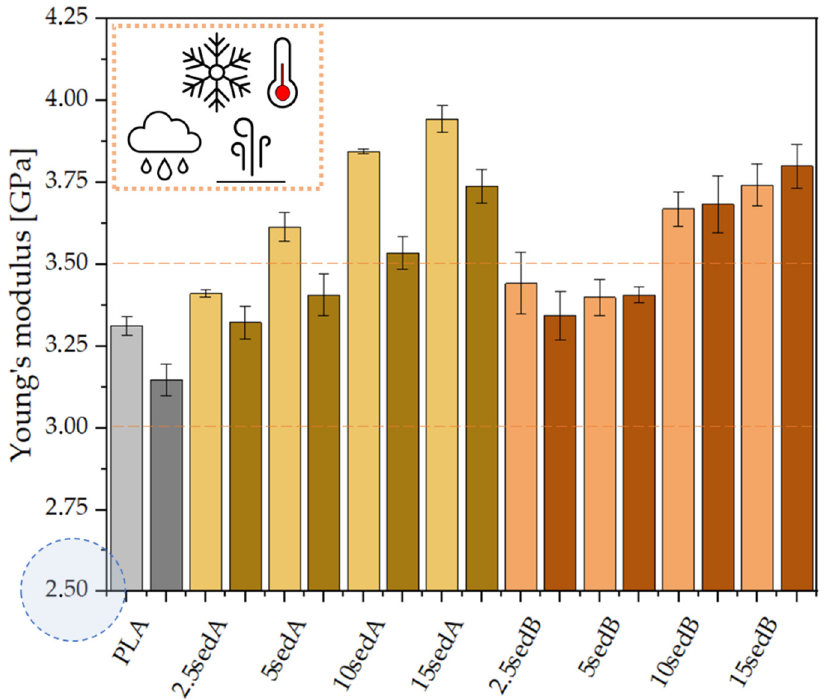
Figure 15. Young’s modulus for the composites PLA/sedA-B after conditioning in the weathering chamber (WCh).